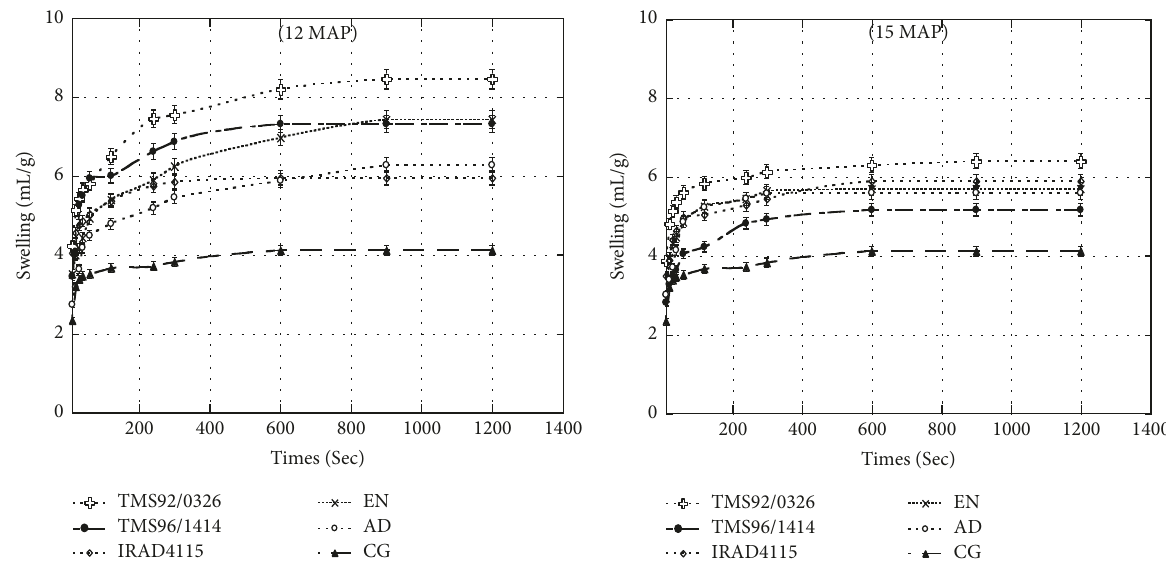
Figure 4: Effect of the harvest period (12 and 15 months after planting) on the swelling kinetic of cassava gari. Garis are produced from local ( EN and AD ) and improved ( TMS92/0326, TMS96/1414, and IRAD4115 ) cassava varieties harvested in dry season at 12 months and in rainy season at 15 months after planting (12MAP and 15MAP). These garis were compared to the commercial cassava gari